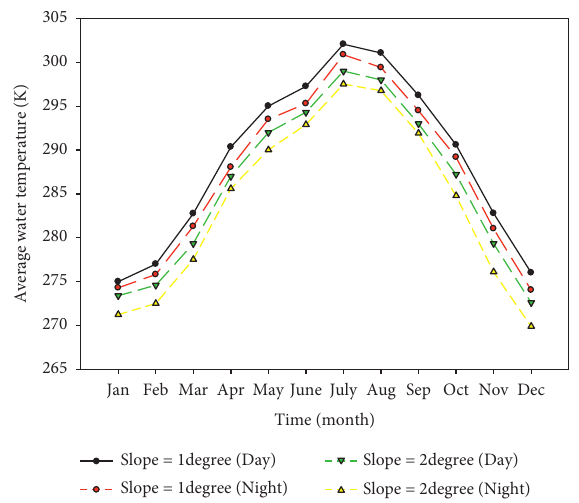
Figure 4: Effect of the inclination angle of the reactor on average water temperature at Re � 9000, water depth � 5.6 mm, and aspect ratio �